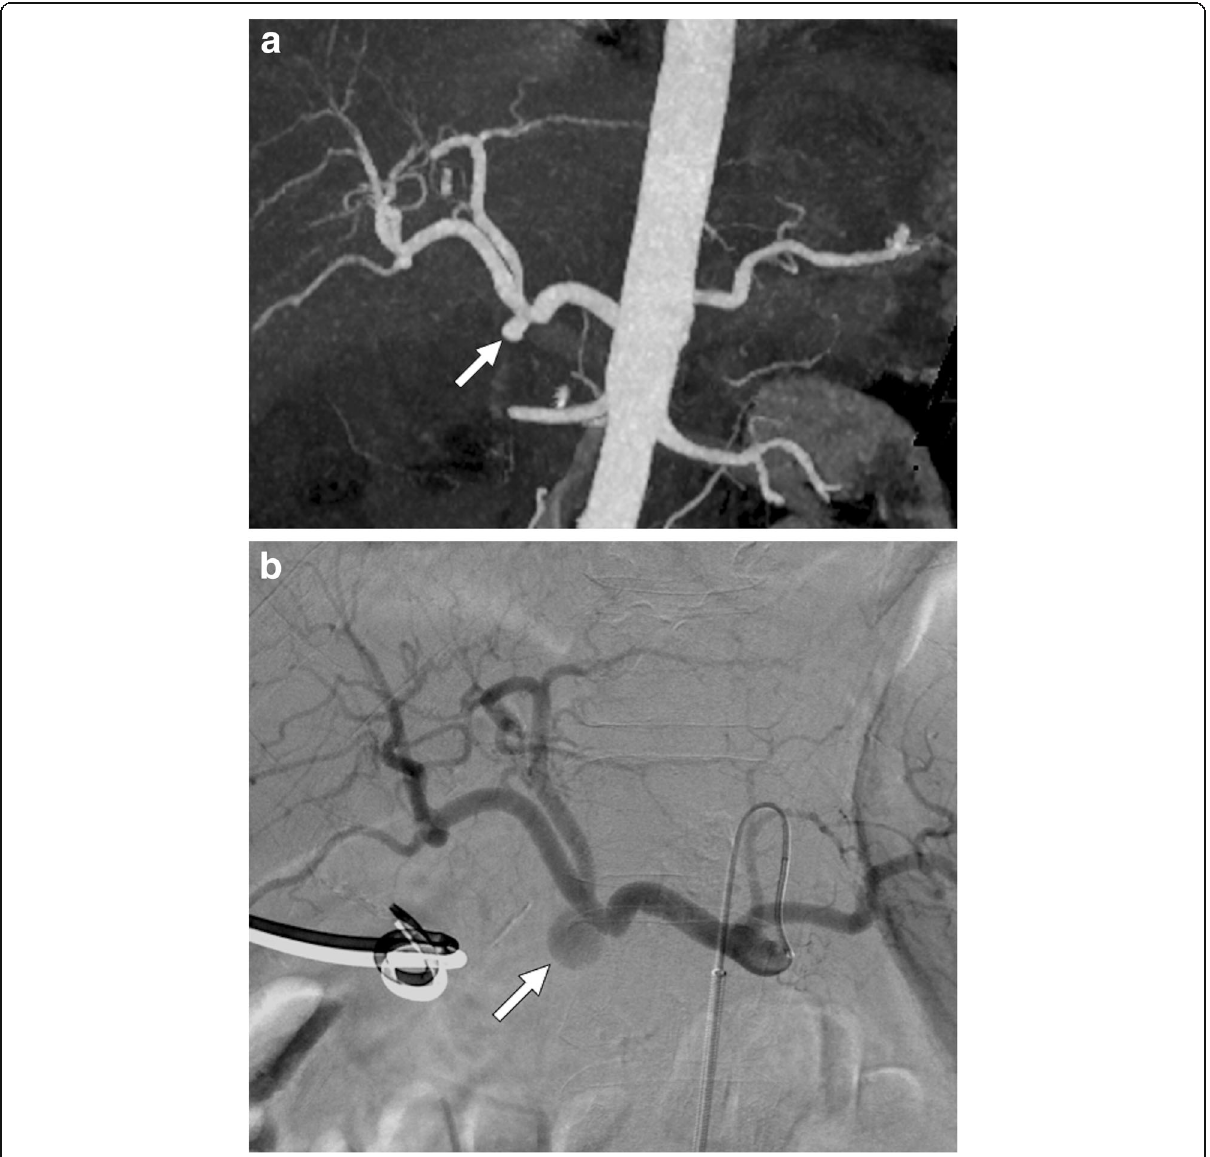
Fig. 29 Gastroduodenal artery pseudoaneurysm. A 55-year-old male patient who underwent Whipple surgery for pancreatic head adenocarcinoma experienced severe abdominal pain and hypotension 2 days after the surgery. a MIP image of arterial phase abdominal CT angiography showed pseudoaneurysm (arrow) at the GDA stump. b Subsequent emergent catheter angiography confirmed the pseudoaneurysm (arrow) at the GDA stump. This pseudoaneurysm was successfully coil